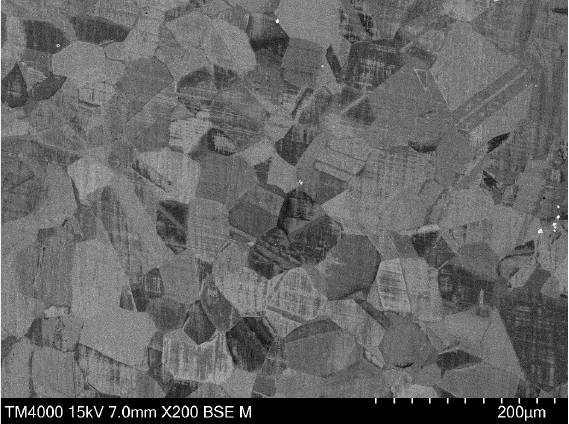
Figure 5. BSE image of the microstructure after solution heat treatment.